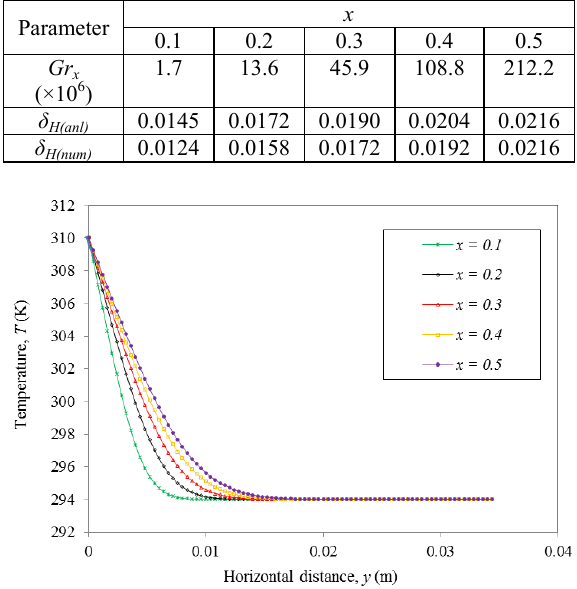
Table 1. Summary of numerical and analytical δ H